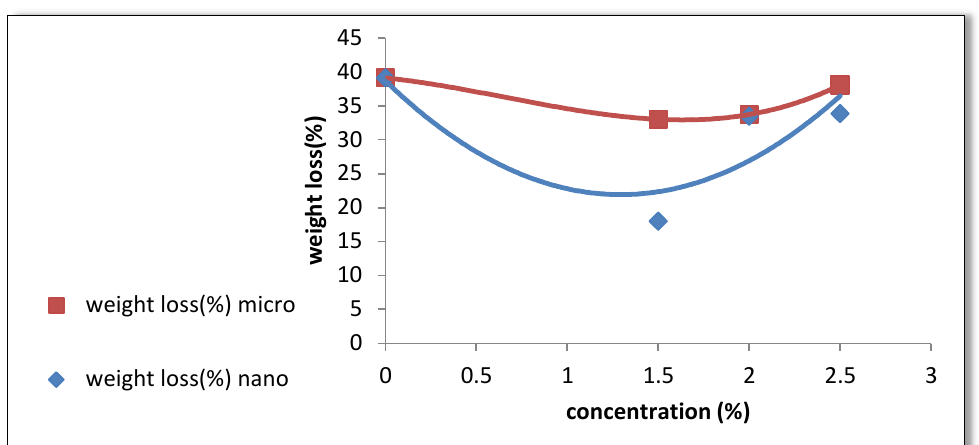
Fig. 7: Enzymatic degradation of SiO